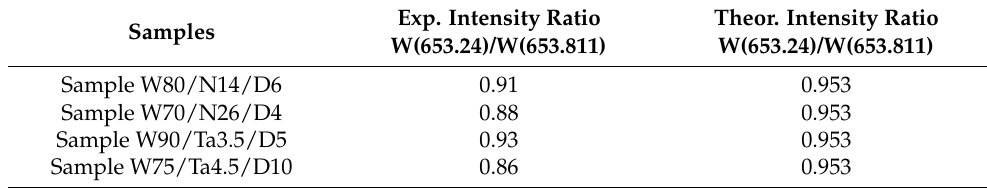
Table 3. Experimental vs. theoretical intensity ratio of W non-resonant lines. Samples